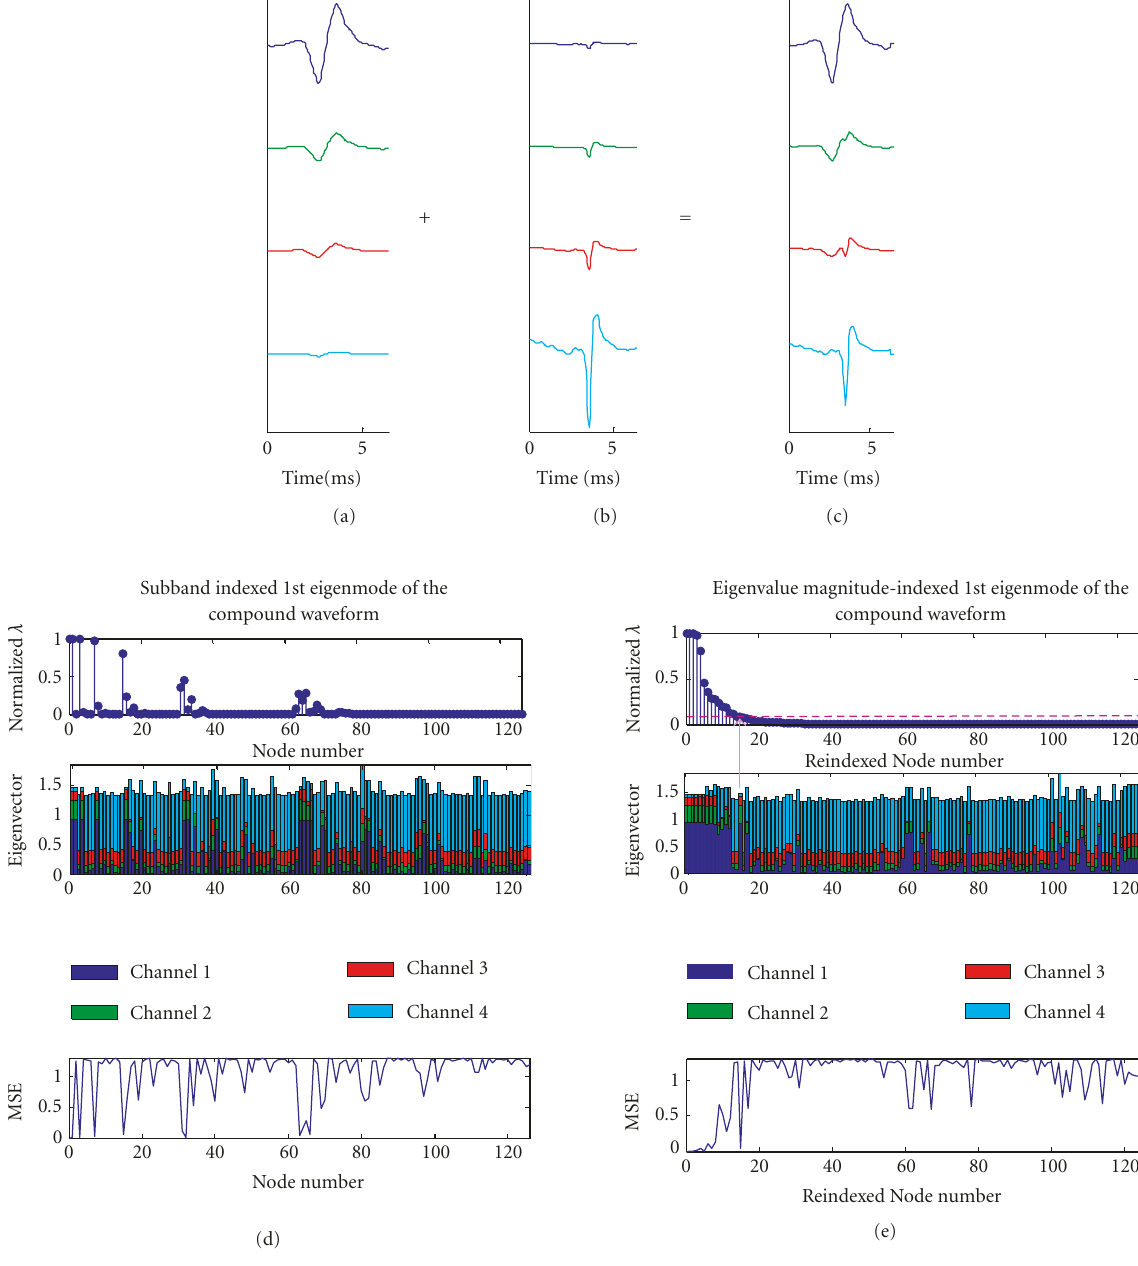
Figure 7: (a), (b) Template sources “ A ” and “ B ” across four channels with distinct mixing. Noise was filtered by averaging detected wave- forms across 200 realizations. (c) Compound waveform obtained by summing the two signal matrices in (a) and (b). (d) 1st eigenvalue (top) and eigenvector (middle) mode of the compound waveform across the DWPT tree. Most of the nonzero eigenvalues correspond to eigenvectors that are similar to u 0 1 . In the bottom is the MSE between u 0 1 and u dominated by source “ A .” (e) Same data in (d) based on arranging λ for λ l 1 (as indicated by the arrow) that coincides with the last node j ∗ having a minimum distance (cid:13) u